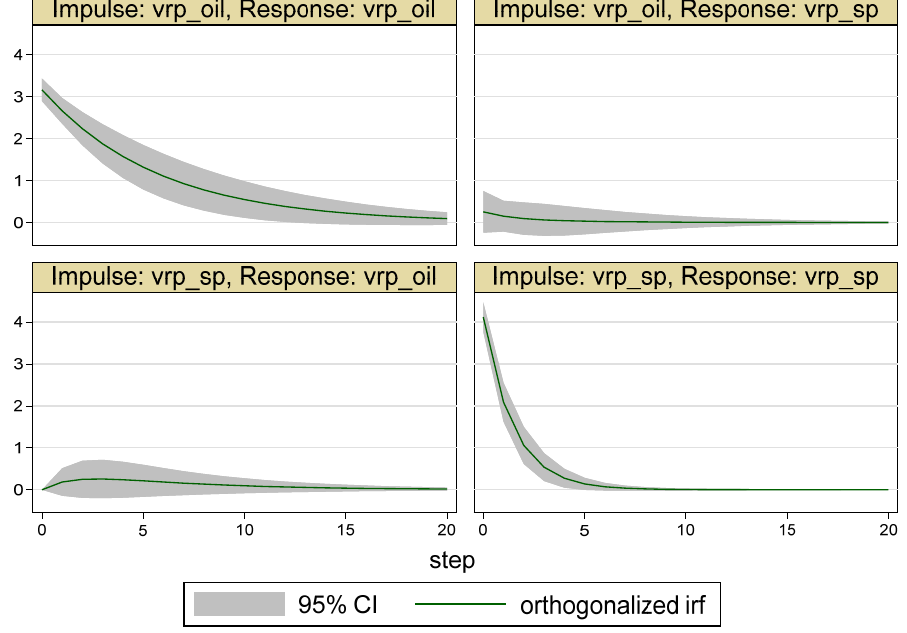
Figure 5. Impulse Response Function (Period 2).